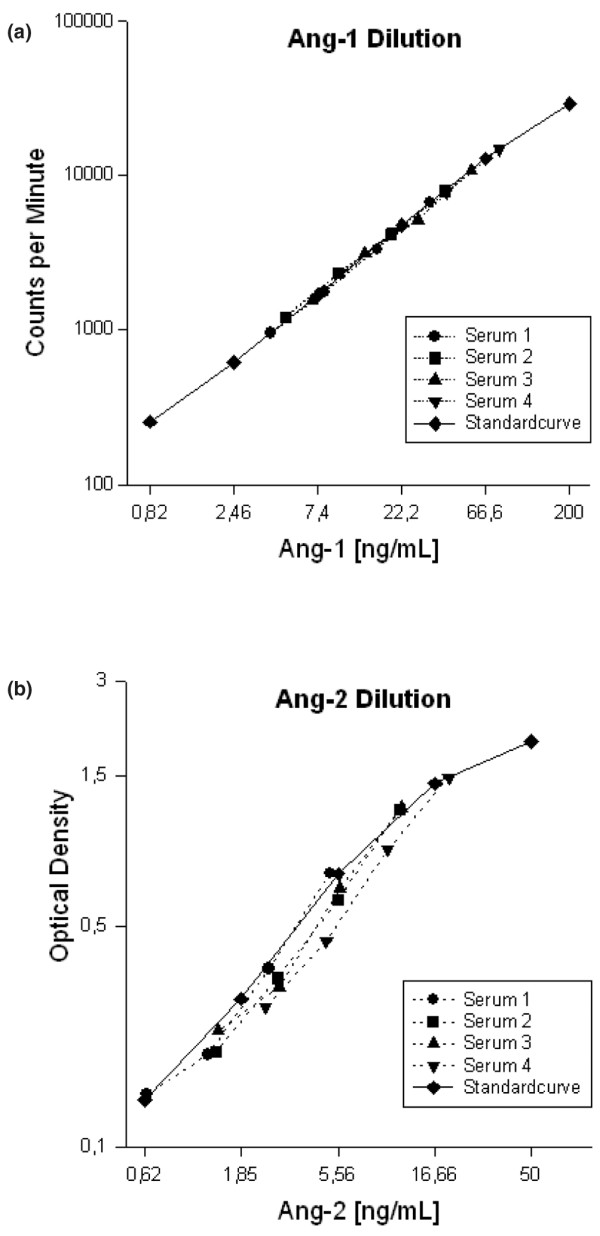
Assay linearity and standard reference curves for angiopoietin-1 and angiopoietin-2 immunoassays. Dilution studies demonstrated both excellent assay linearity as well as adequate parallelism between standard references (recombinant human angiopoietin-1 or recombinant human angiopoietin-2) and serially diluted serum sample curves for (a) angiopoietin-1 (Ang-1) and (b) angiopoietin-2 (Ang-2) assays.